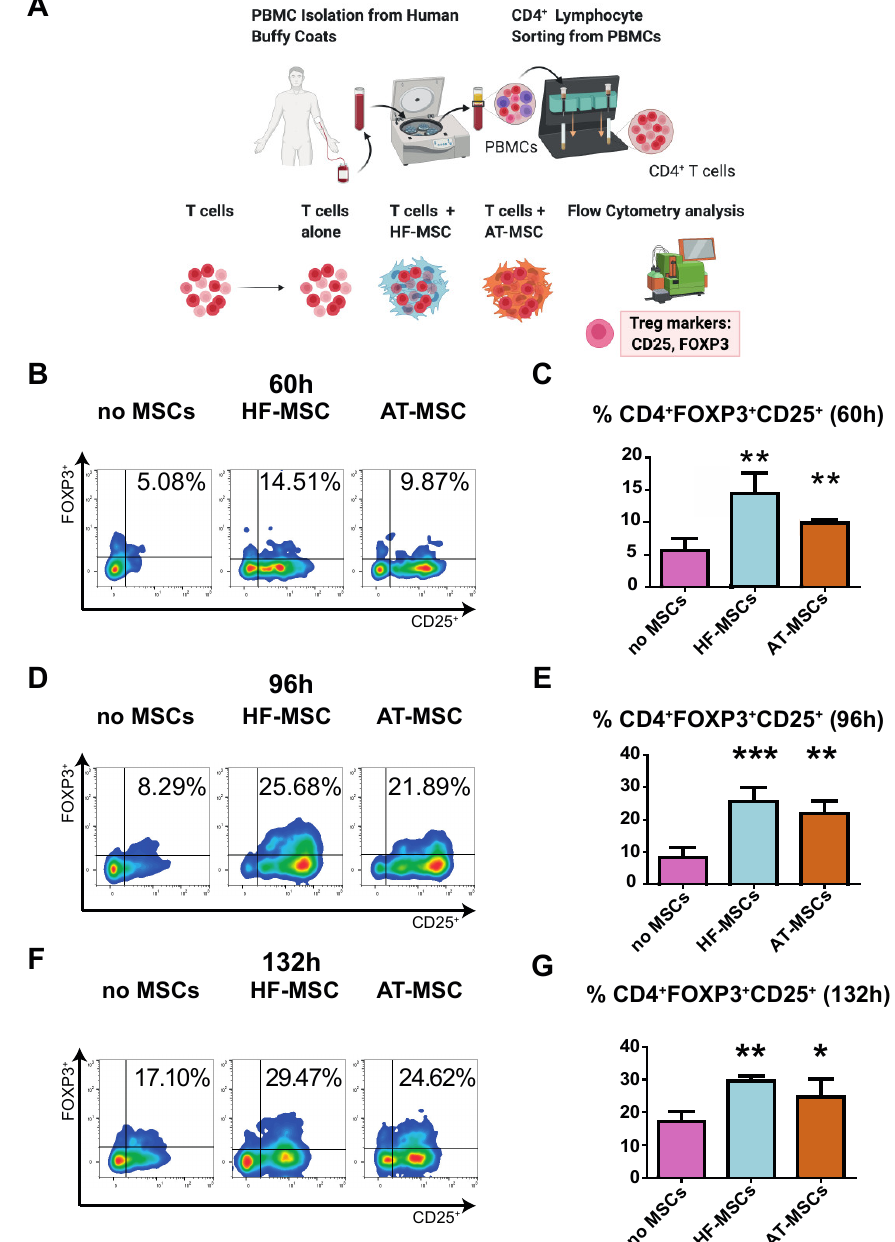
Figure 6. Effect of MSCs on induction of CD4+CD25+FOXP3+ T regulatory cells. ( A ) Schematic of the study. ( B – G ) Dot plots ( B , D , F ) and their bar-graph representations ( C , E , G ) exhibiting the percentages of T regs when cultured alone or with MSCs over 60 h ( B , C ), 96 h ( D , E ) and 132 h ( F , G ). Each data point represents the mean for at least three wells ± SD. Statistical significance: *** p < 0.001, ** p < 0.01, and * p < 0.05 when compared against the control group without MSCs. PBMCs, peripheral blood mononuclear cells. HF-MSCs, hair follicle-derived MSCs. AT-MSCs, adipose tissue-derived